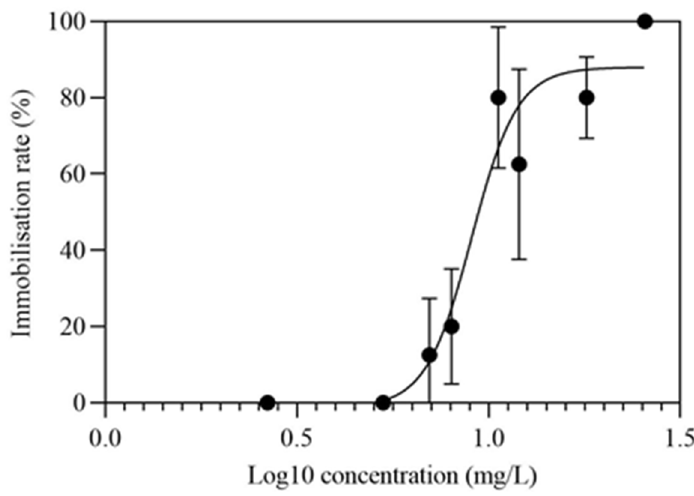
Figure 1. Inhibition rate of D. magna exposed to different PRA concentrations for 48 h ( n = 8).